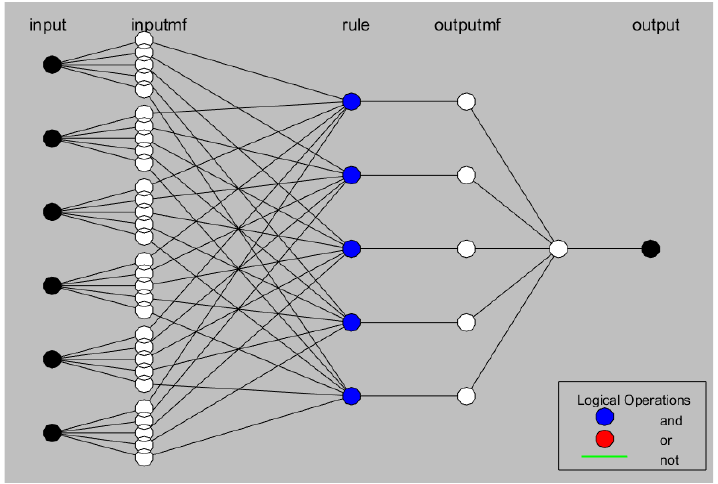
Figure 8. ANFIS structure for formulating input data using the FCM